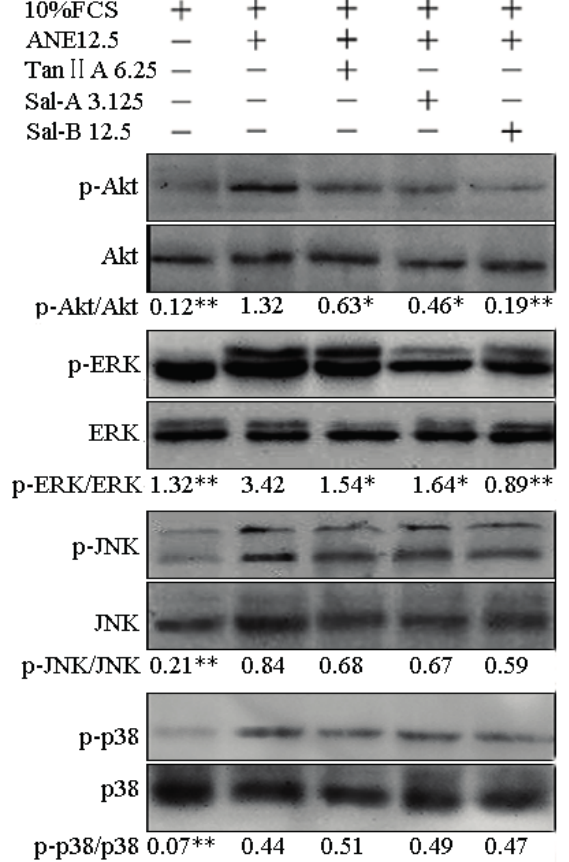
Figure 4. Effect of Tan-IIA, Sal-A and Sal-B on the ANE-induced activation of AKT and ERK/JNK/p38 MAPK pathways. MOMFs were exposed to ANE (12.5 μ g/mL), with or without Tan-IIA (6.25 μ M), Sal-A (3.125 μ M) and Sal-B (12.5 μ M) for 48 h. n = 3, * p < 0.05 and ** p < 0.01 vs. the FCS + ANE